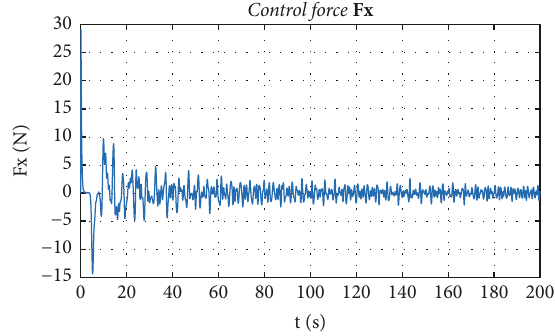
Figure 3: Control force 𝐹 𝑥 without vibration control.